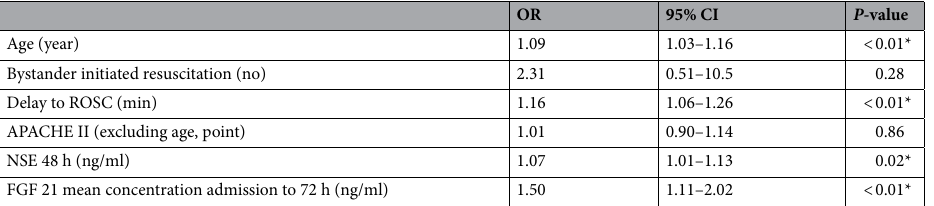
Table 5. Logistic regression model for predicting 6-month Cerebral Performance Categories 2–5 (neurological condition not classified as CPC 1 “good cerebral performance”). OR, odds ratio; CI, confidence interval. *Statistically significant at the P < 0.05